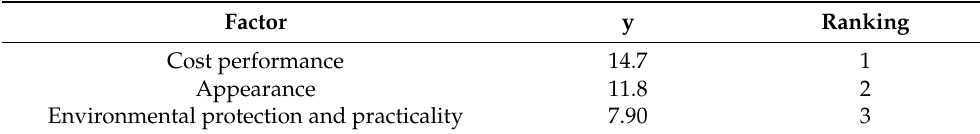
Table 4. The importance ranking of three factors in Question